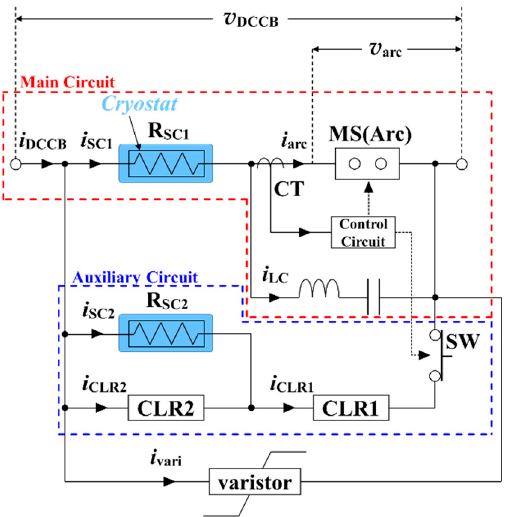
Figure 1. Equivalent circuit of proposed superconducting hybrid DCCB. The auxiliary circuit consists of R SC2 (resistance of HTSC2), CLR1 connected in series, and CLR2 connected in parallel. When RSC1 is quenched, fault current flows toward R SC2 , and the current may or may not flow toward CLR2, depending on the critical current